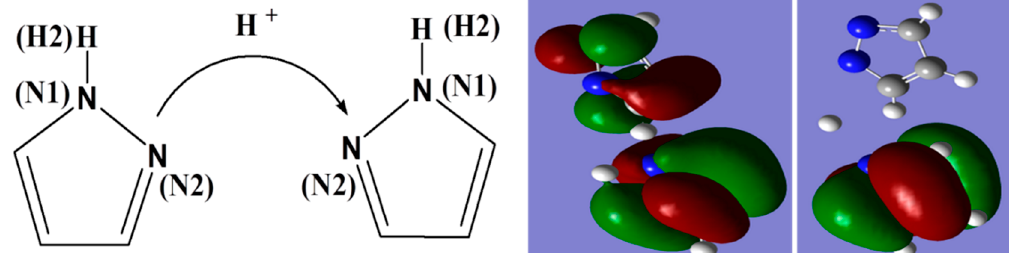
Figure 8. ( a ) The relative distance of a selected proton with N1 (N1 in Py). ( b ) The relative distance of Figure 9. A visual presentation of proton migration along pyrazole groups based on distance analysis. Figure 9. A visual presentation of proton migration along pyrazole groups based on distance analysis. a selected proton with N2 (N2 in Py). Shown on the right-hand side is the DFT computation result of the protonated and deprotonated Shown on the right-hand side is the DFT computation result of the protonated and deprotonated pyrazoles, in qualitative agreement with the molecular dynamics simulation result. pyrazoles, in qualitative agreement with the molecular dynamics simulation